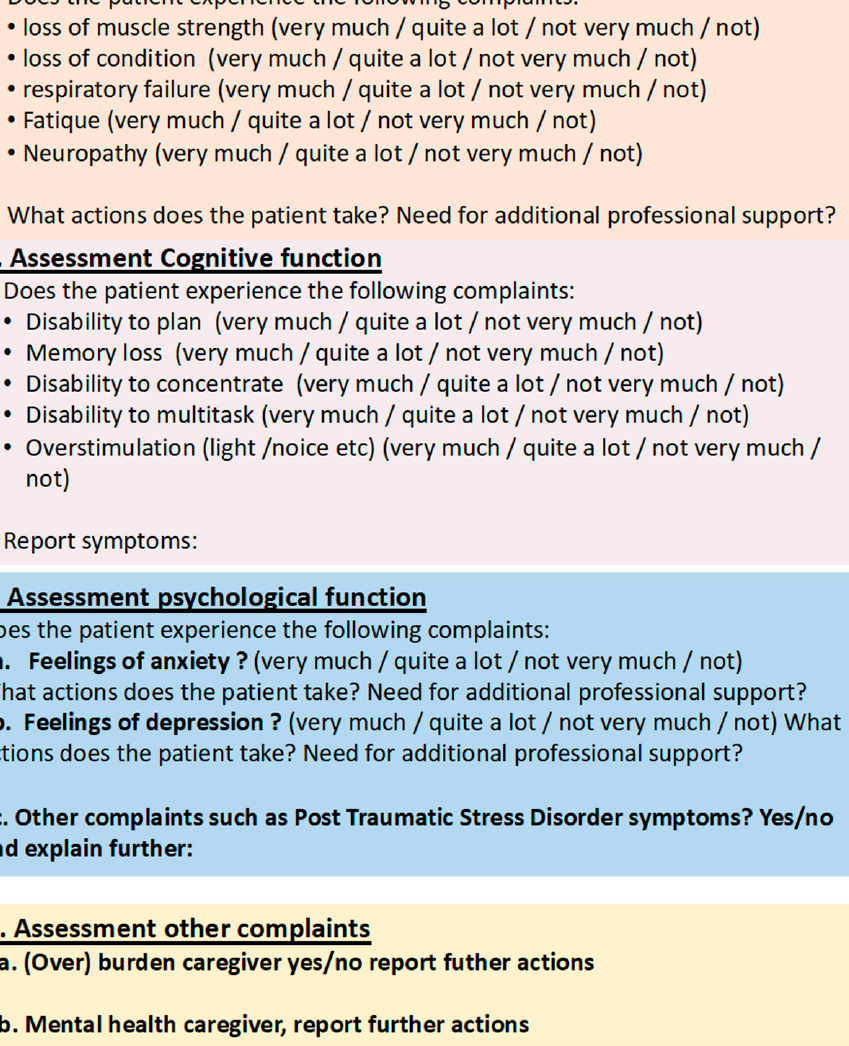
Table A1. Additional symptoms ordered by Post Intensive Care Syndrome (PICS).